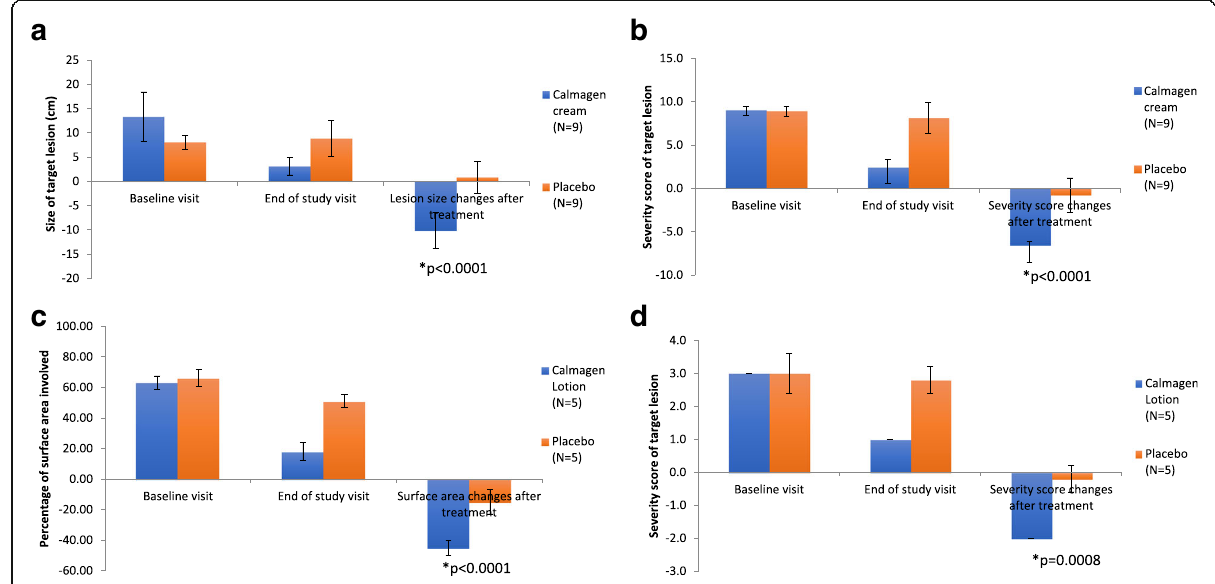
Fig. 3 Calmagen® cream and lotion met secondary endpoints: Changes from baseline and treatment in size ( a ) and in target lesion severity score ( b ) for tinea subjects. Changes from baseline and treatment in surface area involved ( c ) and in target lesion severity score ( d ) for onychomycosis subjects. p -value; *: statistically significant; N: Number of subjects; cm: centimetre; |-|: standard